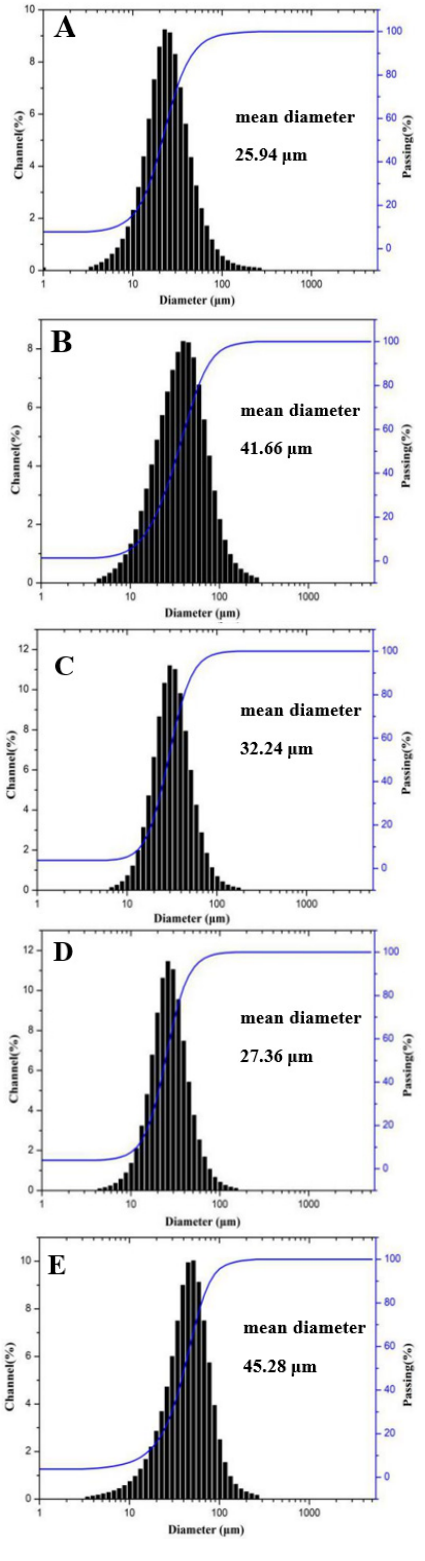
Figure 4. Size distribution of spray-dried microcapsules: ( A ) F1, ( B ) F4, ( C ) F5, ( D ) F6, and ( E ) F7.